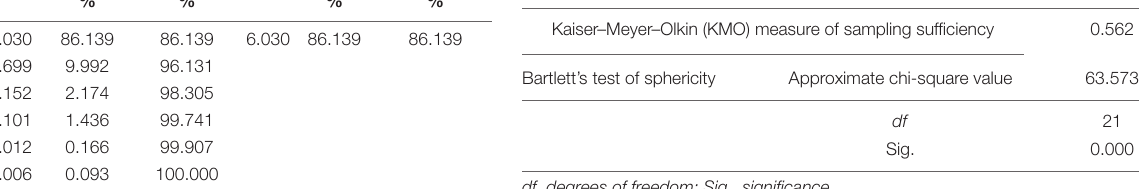
TABLE 8 | Kaiser–Meyer–Olkin (KMO) test and Bartlett’s test of